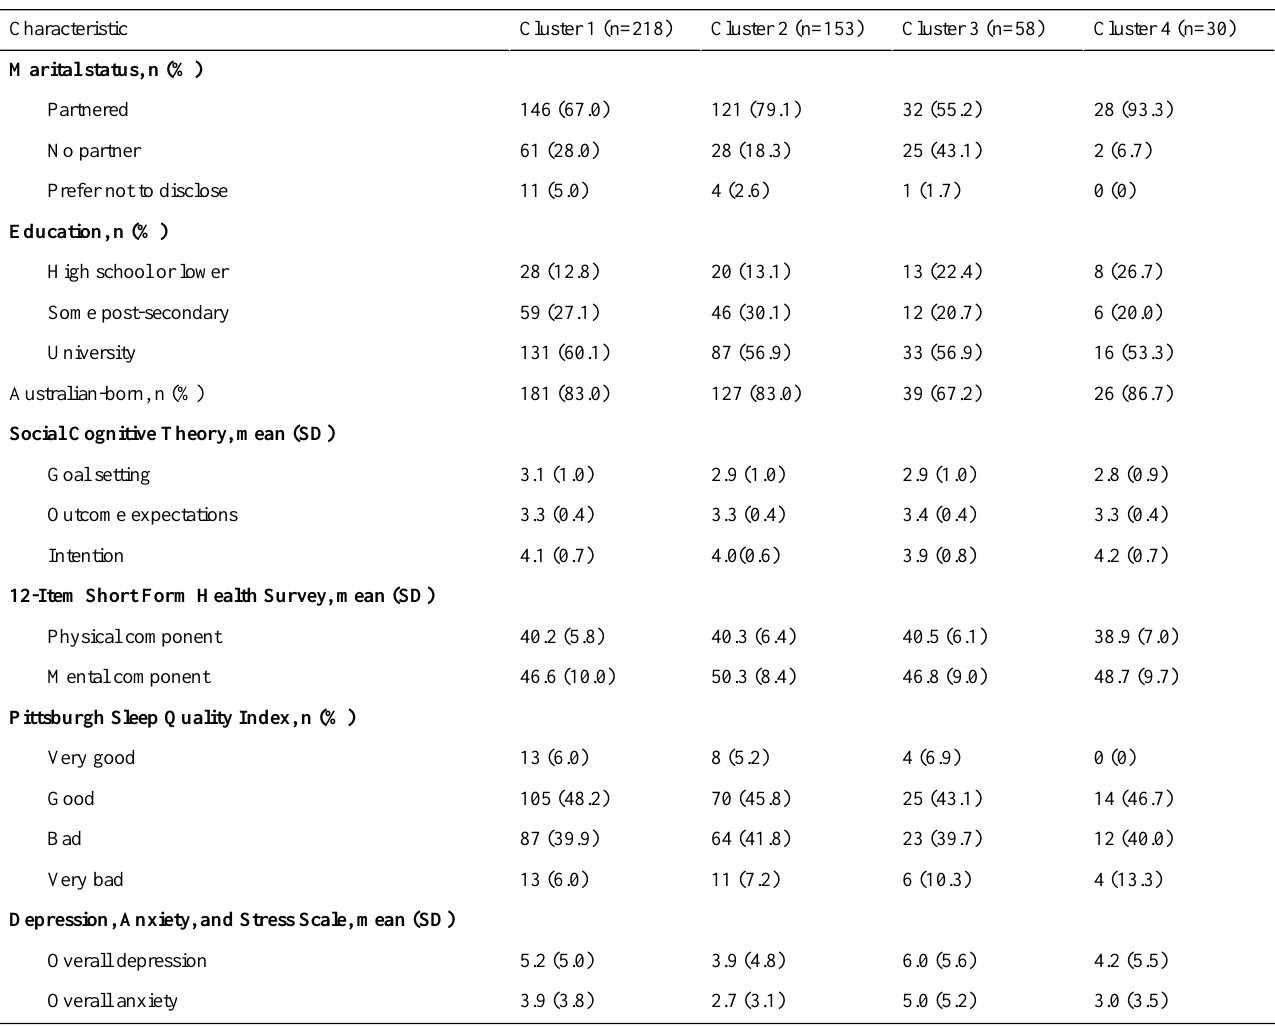
Table 3. Descriptive characteristics of the